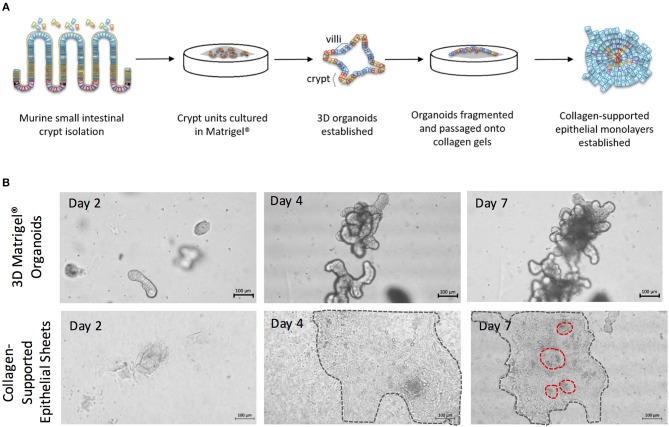
The generation of collagen-supported epithelial sheets through passage of 3D Matrigel®-grown enteroids onto a collagen support. (A) Crypt units were dissociated from small intestinal tissues of C57Bl/6 mice, then cultured in Matrigel® with a cocktail of growth factors and supplements, to establish 3D enteroid cultures. Enteroid cultures were fragmented by syringing and passaged onto collagen supports to generate collagen-supported epithelial sheets. (B) Images depict growth of 3D murine enteroids in Matrigel, or murine collagen-supported epithelial sheets, over a 7 day period. Dotted lines highlight the periphery of epithelial sheets on collagen supports. Scale bars, 100 μm.